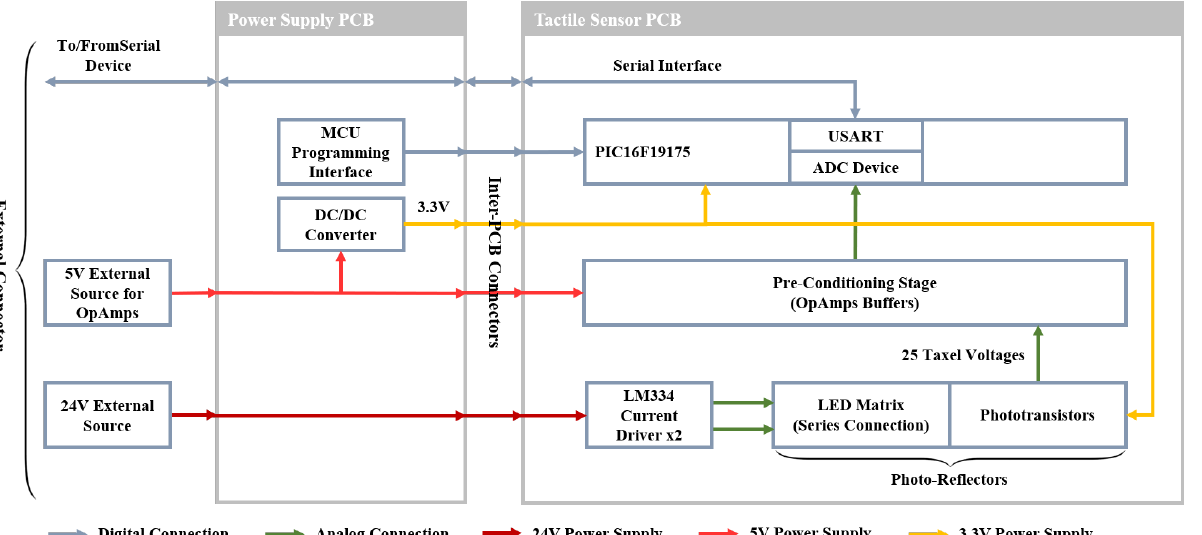
Figure 2. Electronics block diagram.